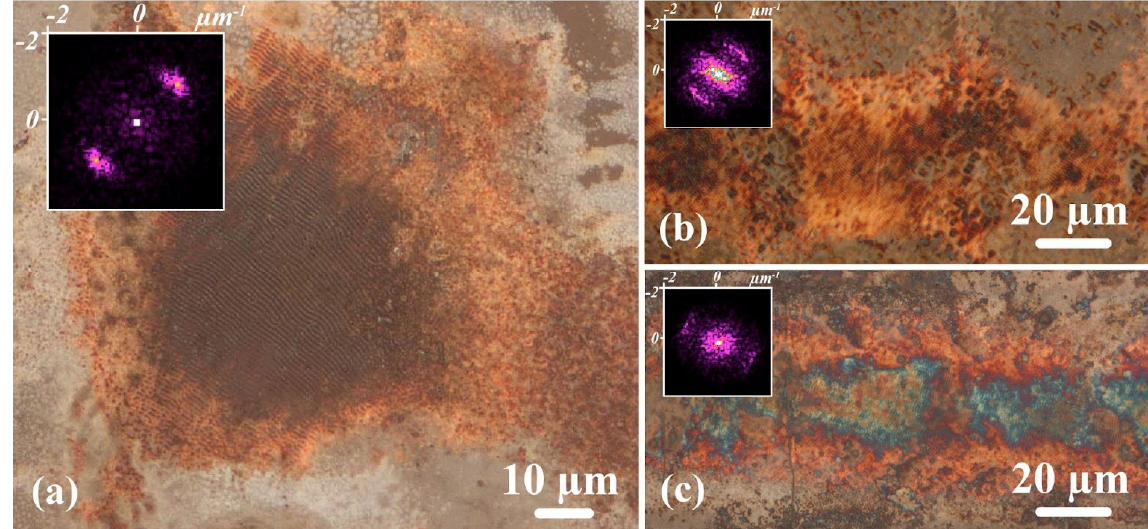
Figure 4. ( a − c ) Morphology of copper tracks recorded with LIPSSs formation. Two-dimensional FFT spectra of the areas with LIPSSs formation are shown on the insets. Recording regime P = 1.85 W, V = 0.05 mm/s, f = 20 kHz, τ = 200 ns, and delay duration before scanning t = 1 s. Structure period is 0.77 ± 0.15 µm, and the dispersion in the LIPSSs orientation angle (DLOA) is about 15 − 25 degrees.